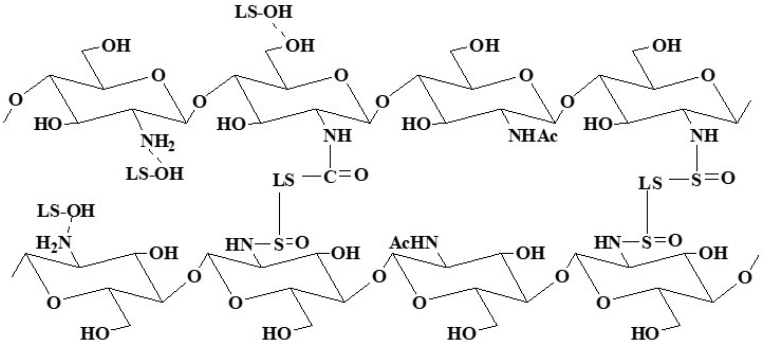
Figure 5. Structure of the L/C (LS refers to sodium lignosulfonate).